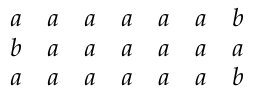
Figure 7. A picture array in L (cid:48)(cid:48)